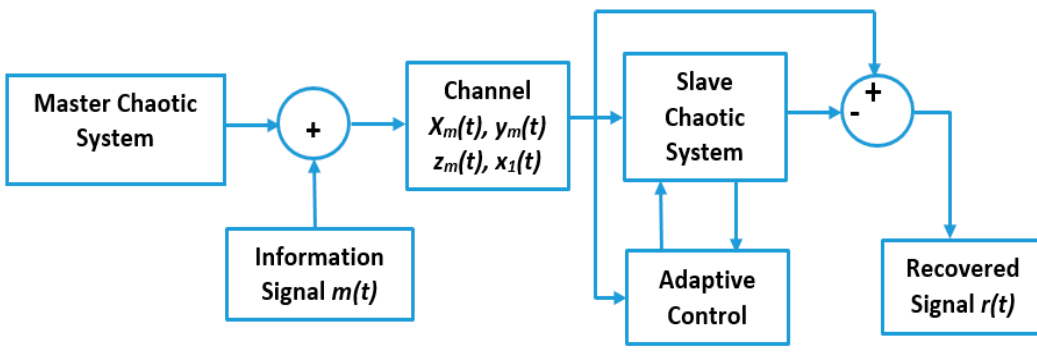
Figure 7. Proposed communication scheme.